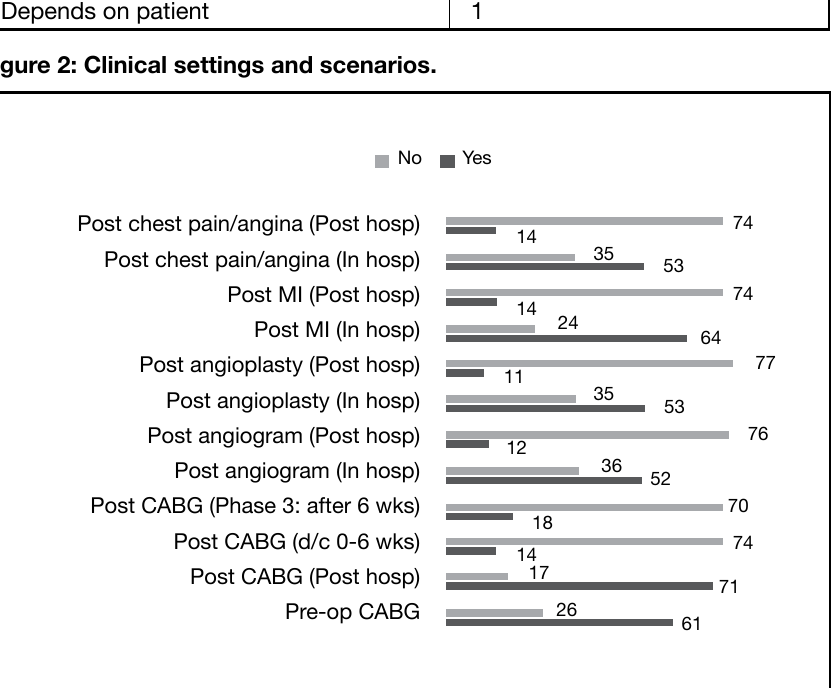
Data expressed as number of physiotherapist working in clinical settings/ scenarios. MI, myocardial infarction; CABG, coronary artery bypass